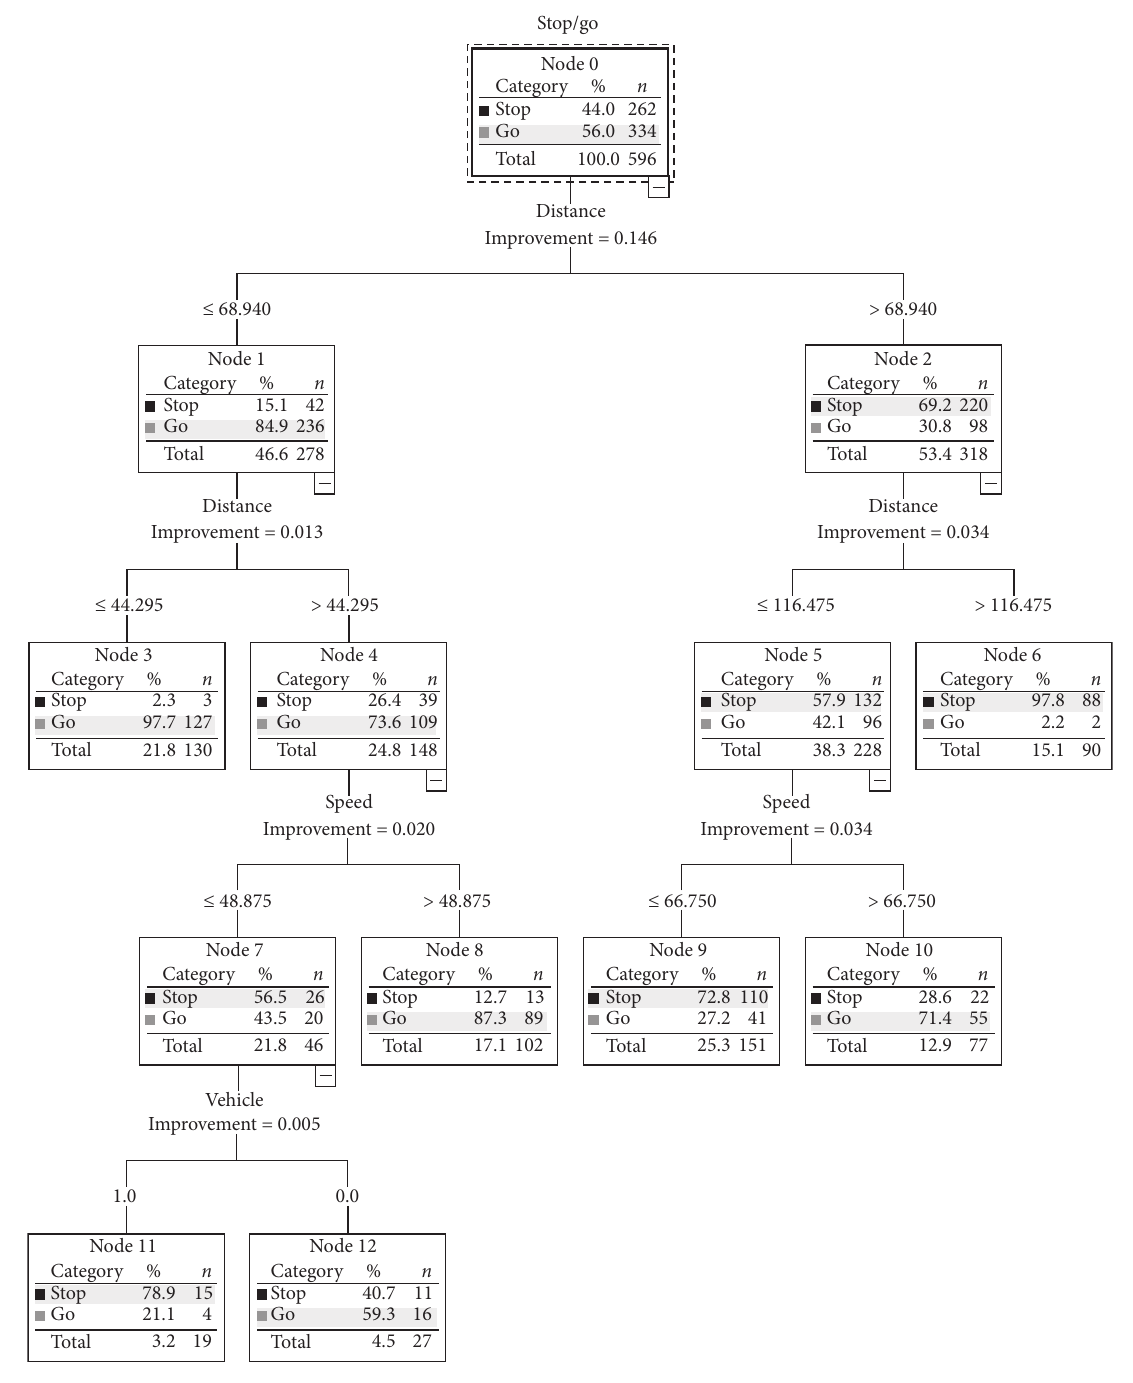
Figure 4: DTC analysis results for rural high-speed intersections (training